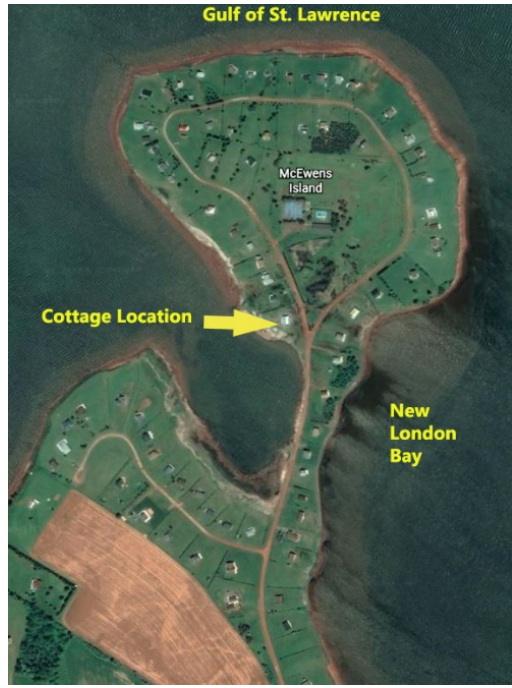
Figure 12. Provides the Cottage Location on MacEwen’s Island in New London Bay, PEI.